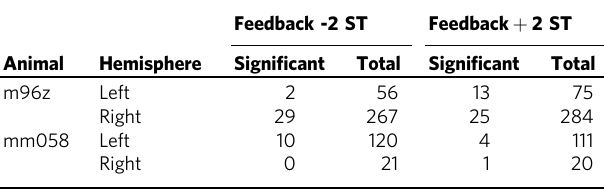
Number of units with signi fi cant vocal correlations is shown, separated by feedback condition, animal, and